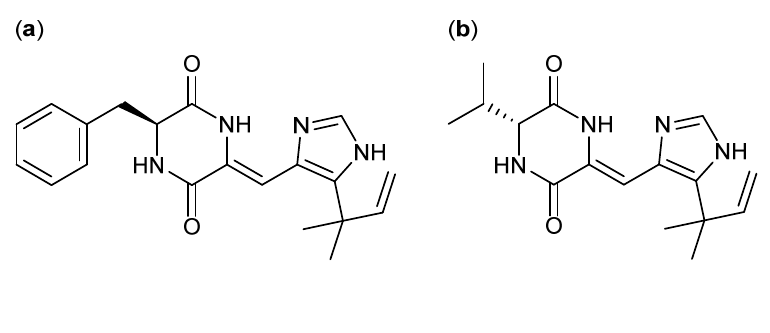
Figure 14. ( a ) Phenylahistin and ( b )